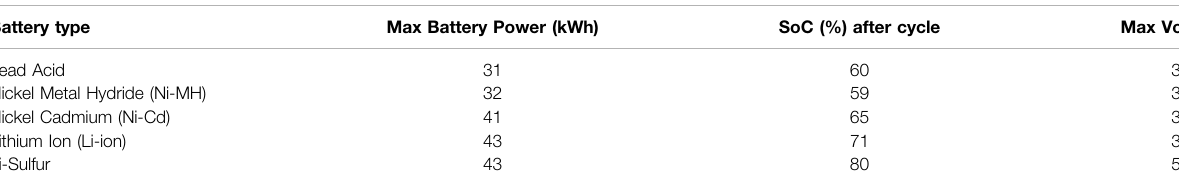
TABLE 4 | Simulation results of different battery types.